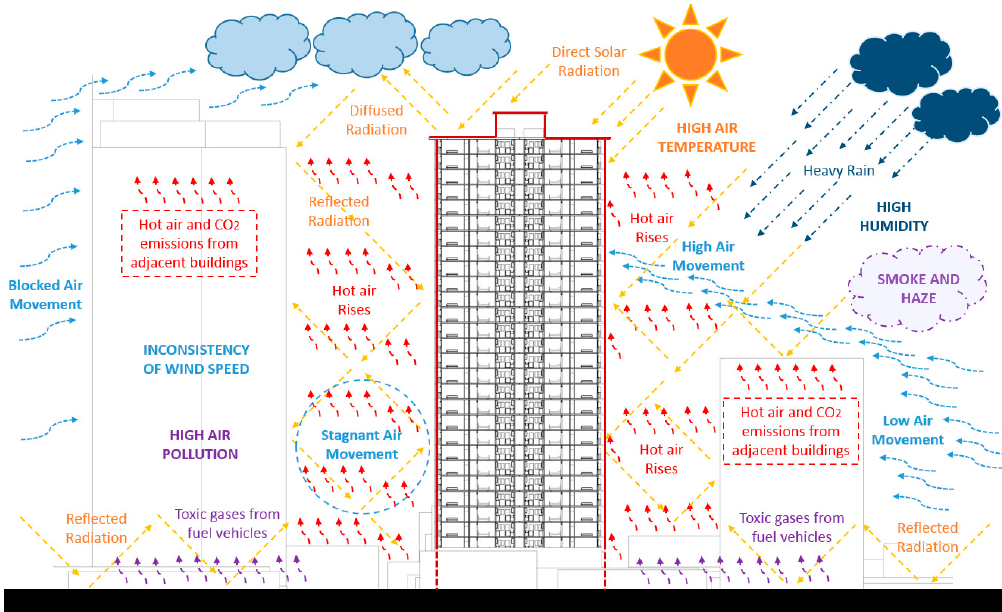
Figure 2. Factors affecting indoor comfort in a typical high-rise building within an urban area in a hot-humid climate.